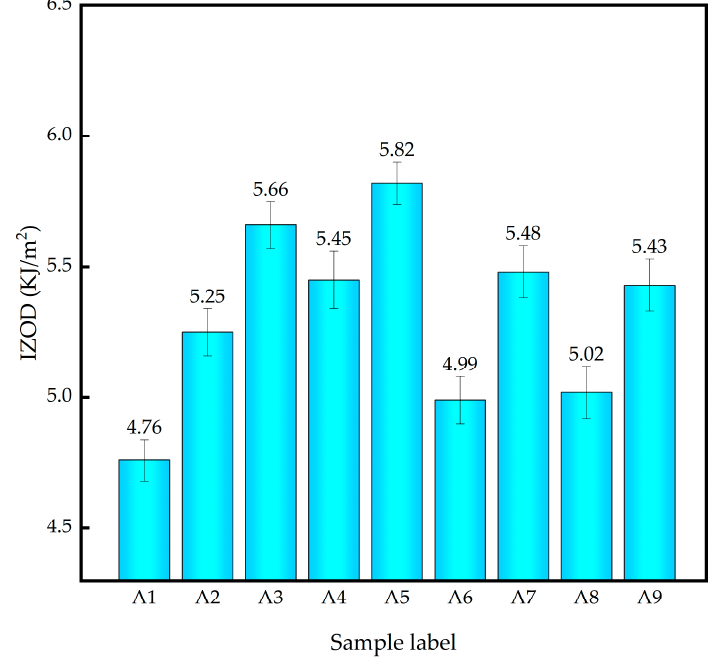
Figure 3. Izod impact strength of different PLA/PBS composites.